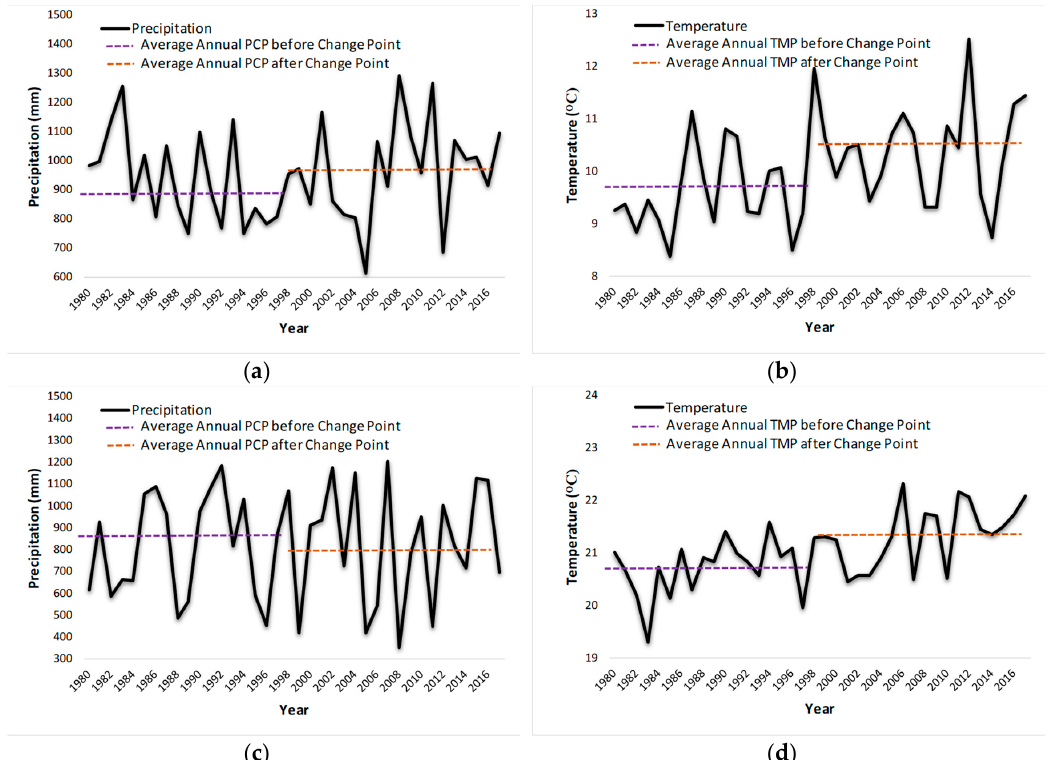
Figure 4. The MK trends for annual precipitation ( a ) and temperature ( b ) in the UWBDR watershed; and annual precipitation ( c ) and temperature ( d ) in the Walzem Creek watershed. Table 4. Temporal trends in annual precipitation and temperature in the study areas.